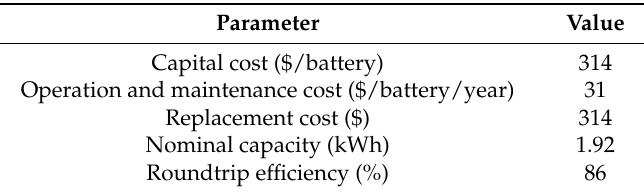
Table 3. Specifications of selected battery.